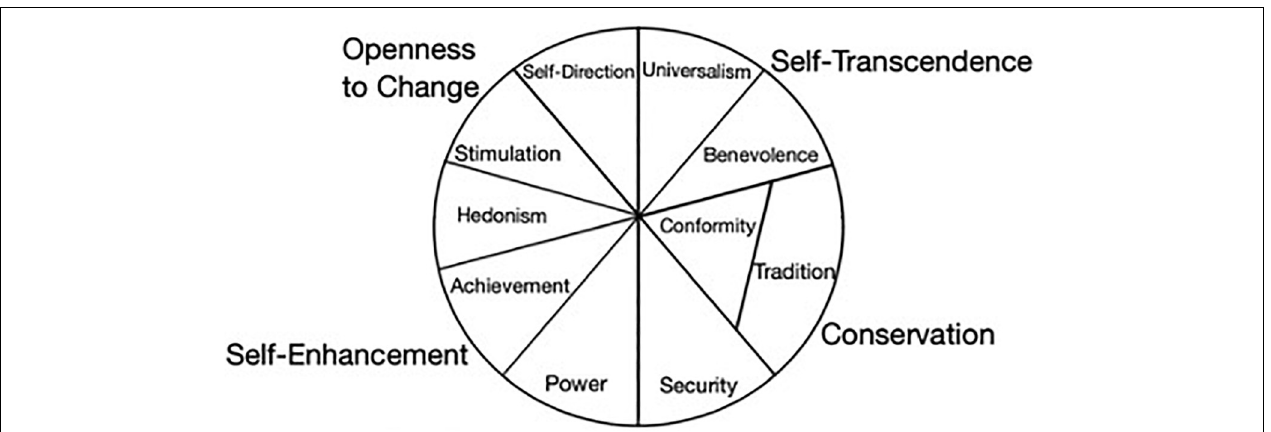
FIGURE 2 | Relationship among value priorities (adopted from Schwartz,